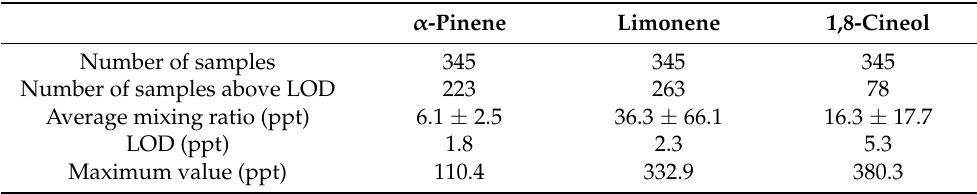
Table 1. Total number of samples, number of samples with monoterpene mixing ratios above LOD, average monoterpene mixing ratio (in ppt), LOD and maximum measured mixing ratios for each monoterpene. α -Pinene Limonene 1,8-Cineol Number of samples 345 345 345 Number of samples above LOD 223 263 78 Average mixing ratio (ppt) 6.1 ± 2.5 36.3 ± 66.1 16.3 ± 17.7 LOD (ppt) 1.8 2.3 5.3 Maximum value (ppt) 110.4 332.9